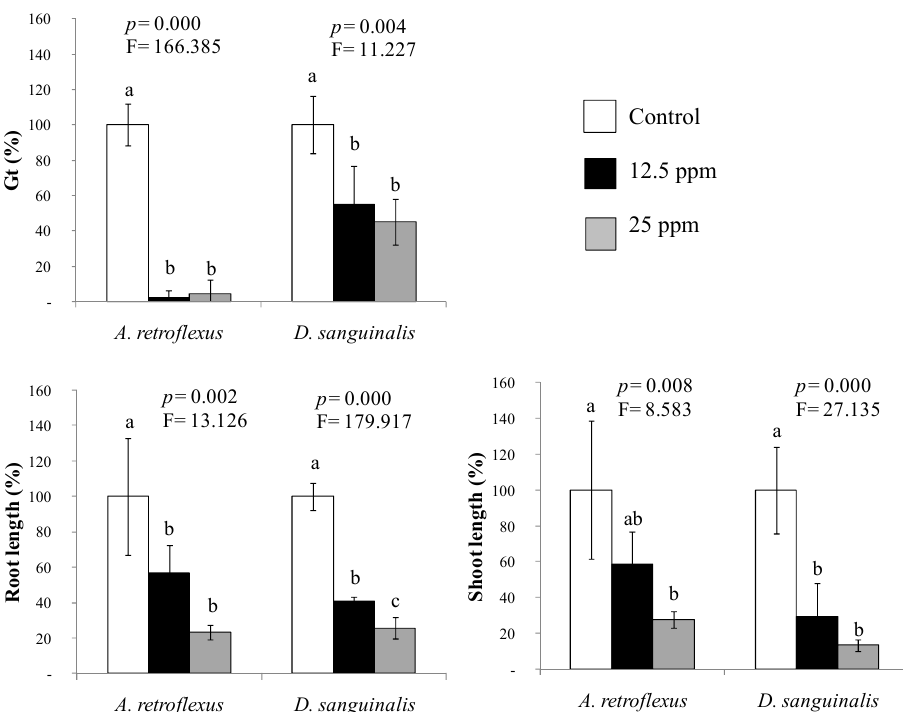
p= 0.000 F= 179.917